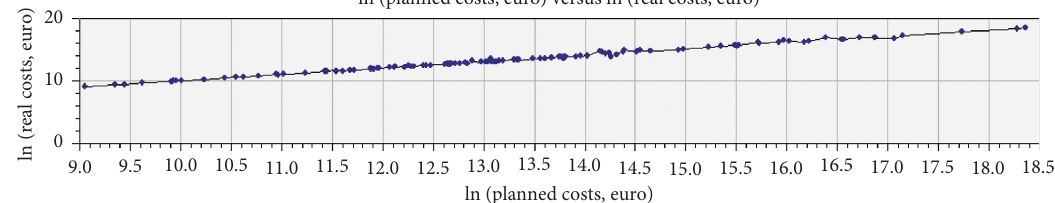
Figure 4: Dependence between the predicted target values (ln (real cost, euro)) and the values of the most important predictor (ln (planned costs, euro)).